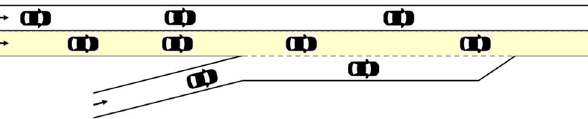
Figure 1 Merging scenario of single-lane freeways with a total CAV penetration